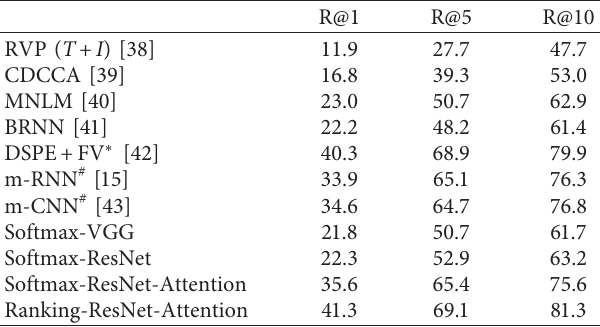
Table 3: The results of different caption methods on the Microsoft COCO.